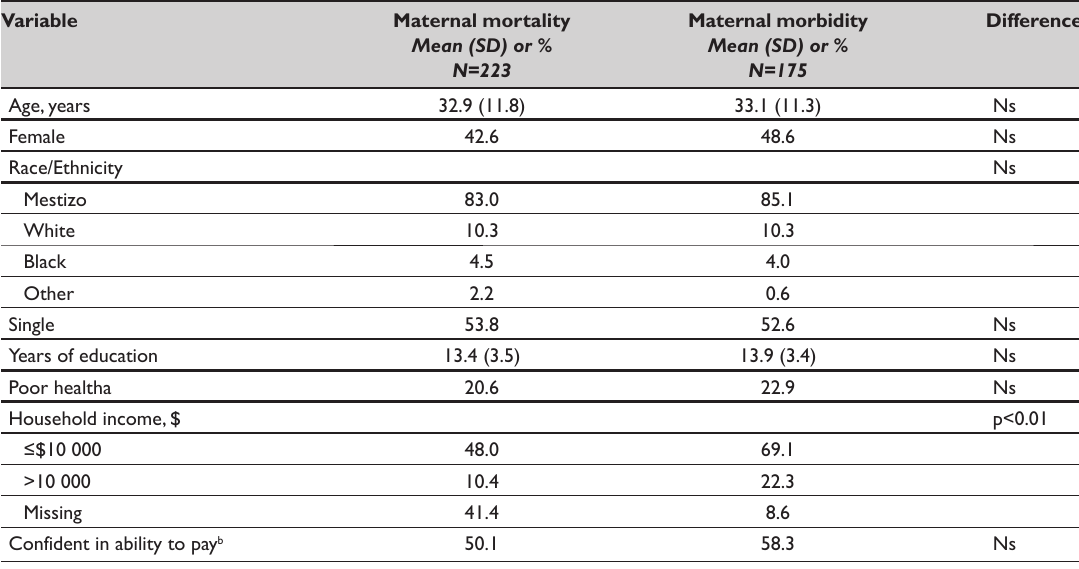
Table 1: Social Demographic Description of Study Participants Variable